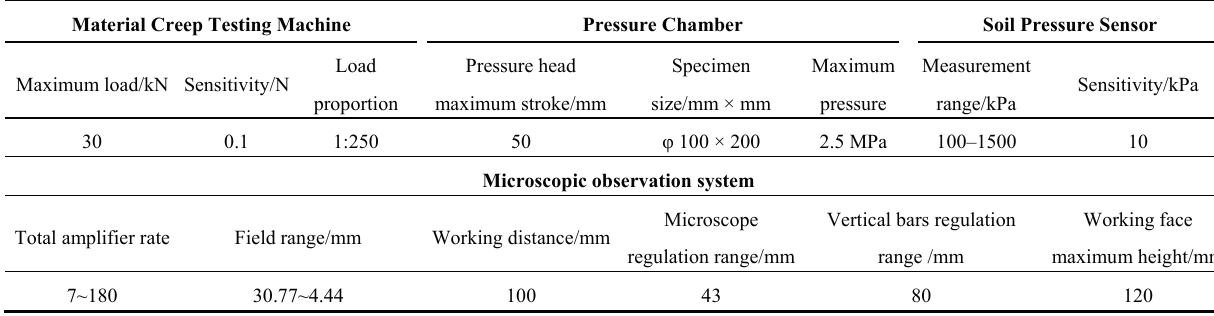
Table 1. Technical parameters of the apparatus.